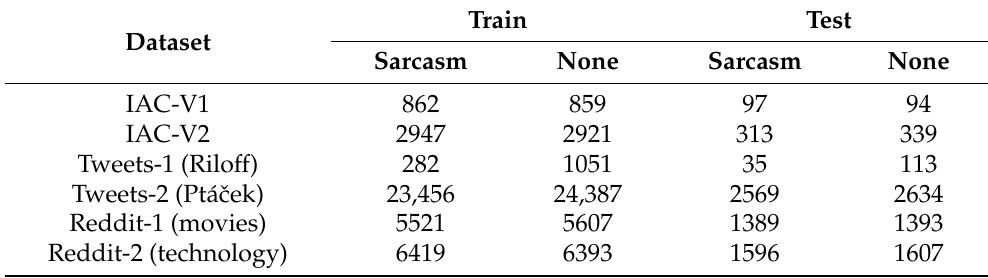
Table 1. Statistics of the experimental data. Train Test Dataset Sarcasm